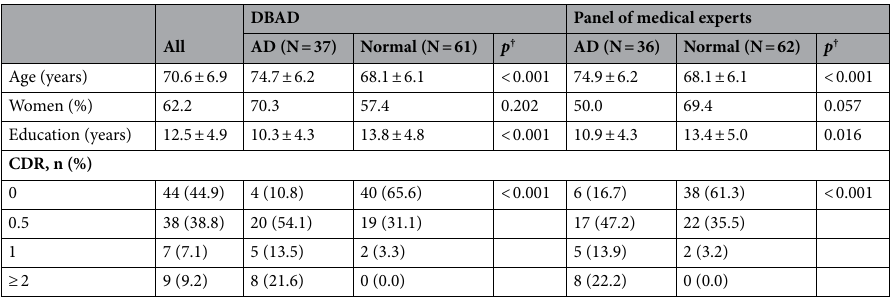
Table 1. Demographic characteristics of the participants. Continuous variables are presented as mean ± standard deviation. DBAD VUNO Med-DeepBrain AD, AD Alzheimer’s disease, CDR Clinical Dementia Rating. † Student’s t-test was used for continuous variables and the chi-square test for categorical variables.